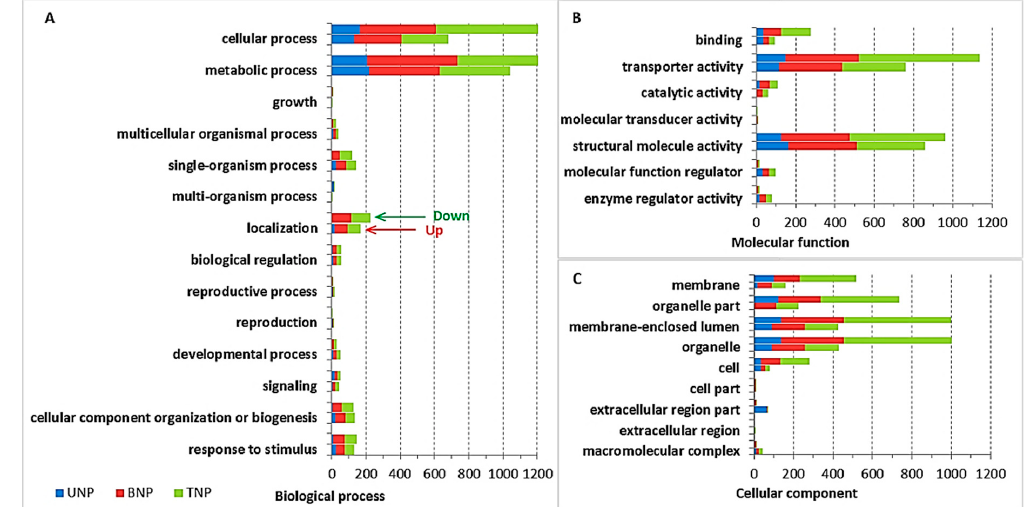
Figure 4. Gene Ontology (GO) analysis of the differentially abundant proteins (DAPs). ( A ) Biological process; ( B ) Molecular function; ( C ) Cellular component. The vertical axis shows the annotations of the GO classifications for DAPs. The horizontal axis represents the numbers of proteins annotated in each pathway, i.e., cellular components, molecular function, and biological process, and the proportion represents the number of proteins. UNP represents the uninucleate stage proteins, BNP represents the binucleate stage proteins, and TNP represents the trinucleate stage proteins. Red arrows indicate the decreased expression of DAPs and green arrows denote the increased expression of DAPs.